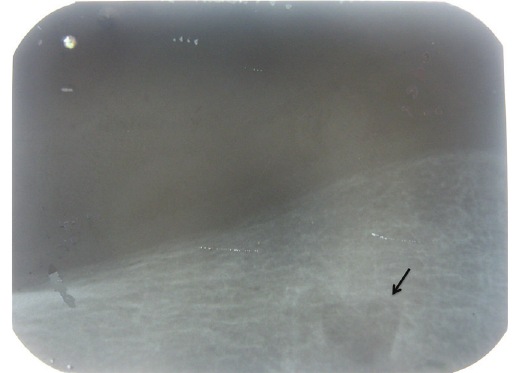
Figure 6: Postsurgical intraoral periapical radiograph showing the enlarged mental foramen with complete absence of the foreign material.